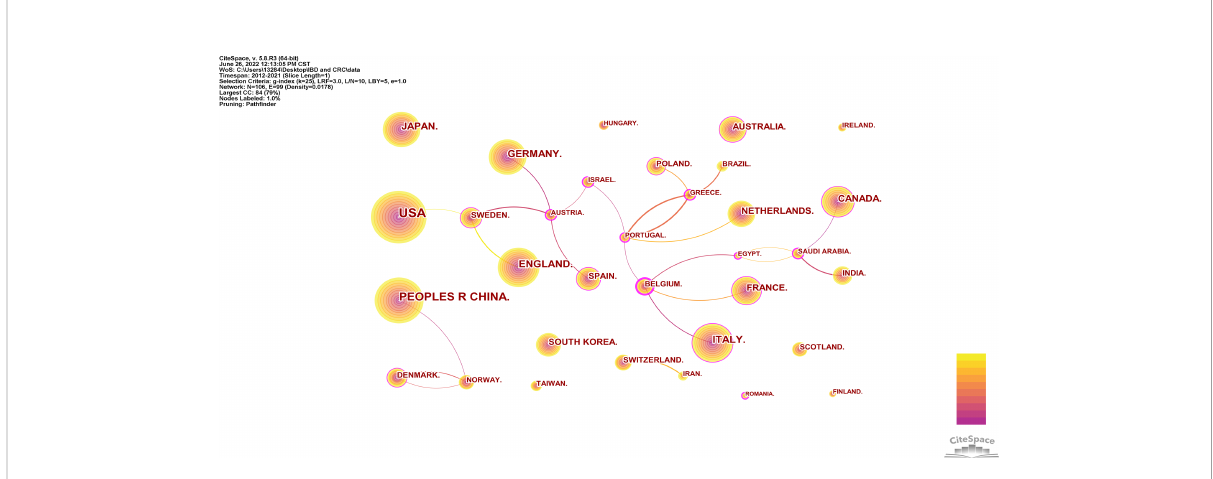
FIGURE 3 Visualization of cooperative relations of countries with more than 20 articles.